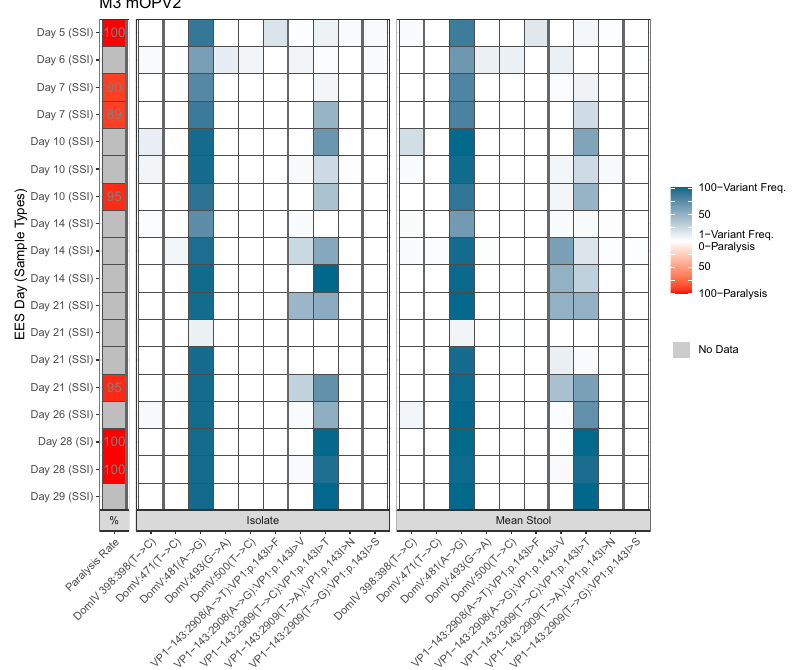
Fig. 4 mOPV2. Frequency of variants in EES at known attenuation sites and mTgmNVT results. Data from M3 phase 4 trial. EES day shown with mTgmNVT result (red colour gradient) and variant frequency (blue colour gradient) averaged across two stool replicates (SS) and culture- ampli fi ed virus (I), if present. Amino acid associated with variant indicated, if applicable. S = Stool replicate; I = Culture-ampli fi ed virus isolate (SSI = Two stool replicates and culture-ampli fi ed virus isolate; SI = Single stool replicate and isolate). White cells = variant not detected. Grey cells = mTgmNVT result not available. The NGS pipeline reports the variants as SNPs. Coding impact assumes changes are not in common genomes when multiple variants are observed in VP1-143. All variants reported have Quality scores (Q scores) ≥